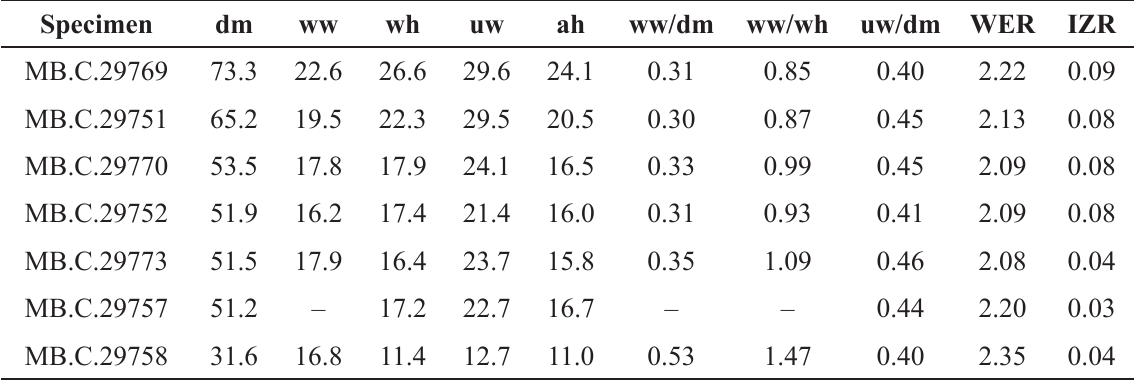
Table 10. Conch dimensions (partly estimated) and ratios of selected specimens of Paratirolites lanceolobatus Korn & Hairapetian sp. nov. from Baghuk Mountain.